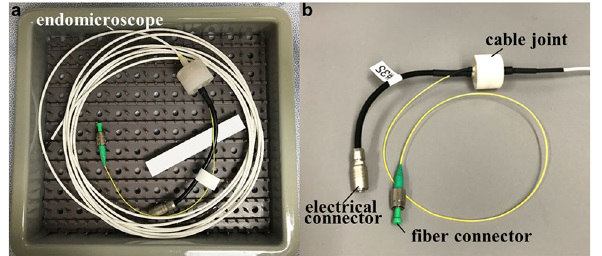
Figure 8. Instrument reprocessing. ( a ) The endomicroscope was placed in a tray after each procedure for sterilization with the STERRAD reprocessing process. ( b ) The SMF and wires were terminated with fiber and electrical connectors, respectively, that were capped prior to